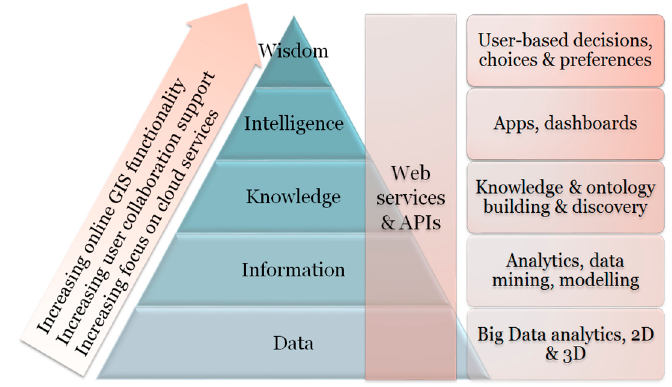
Figure 8. Focus and trends in increasing web mapping functionality.